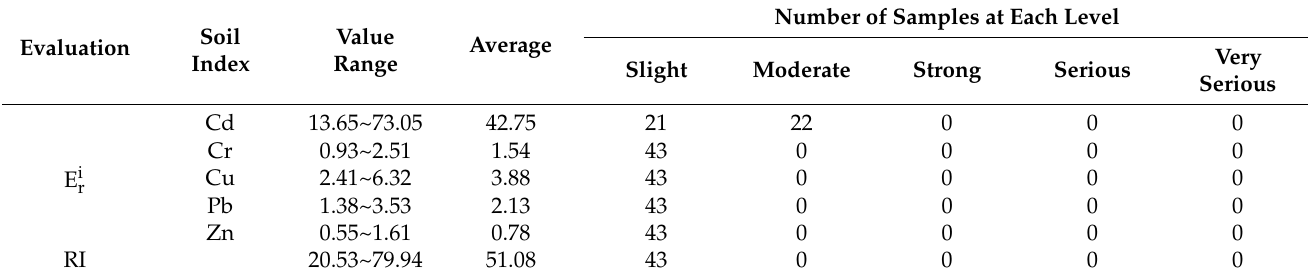
Figure 5. Spatial distribution of single factor index ( P i ) and Nemerow comprehensive index ( P n ) in the study area. Table 7. Evaluation results of potential ecological risk of soil heavy